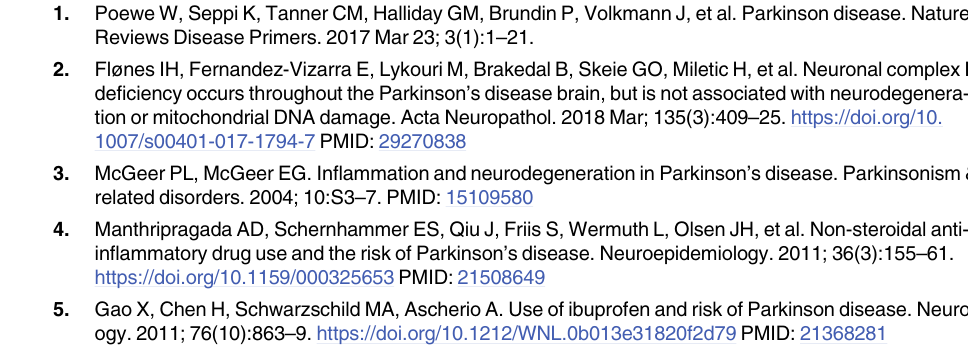
S1 Table. Demographics and descriptive statistics for Norwegian Prescription registry groups used in time-dependent Cox regression analysis with 90DDD a threshold. S2 Table. Demographics and descriptive statistics for Norwegian Prescription registry groups used in binary logistic 5-year lag regression analysis with 90DDD a